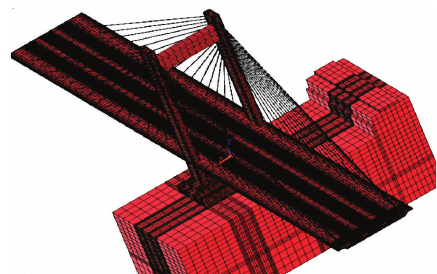
Figure 7: Finite element model.